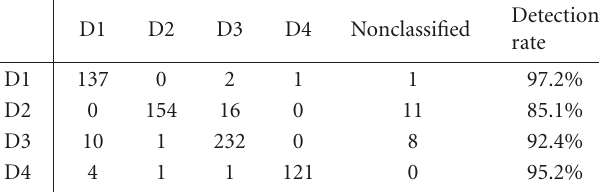
Table 6: Classification results for data from network A, where the SVM is trained with data from network B.